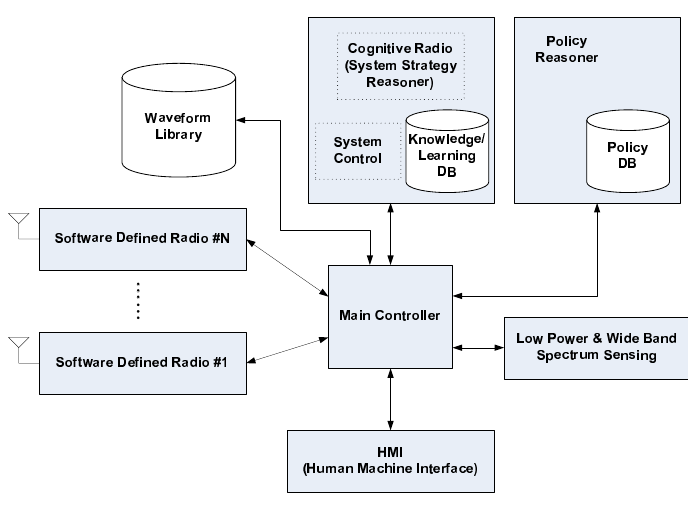
Figure 1. DARPA XG cognitive